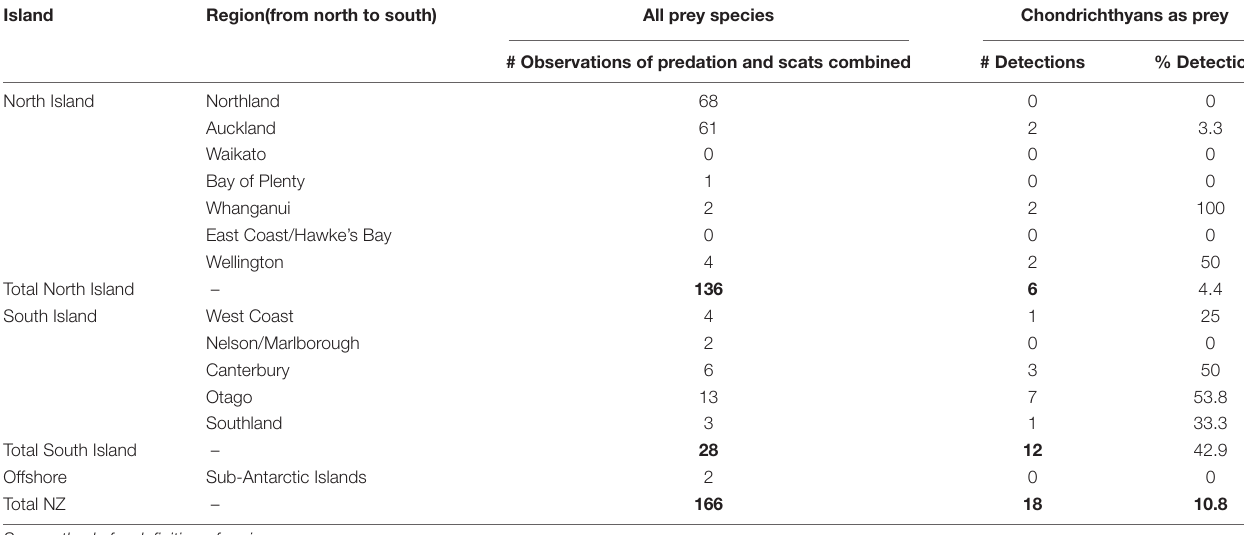
See methods for definition of regions.